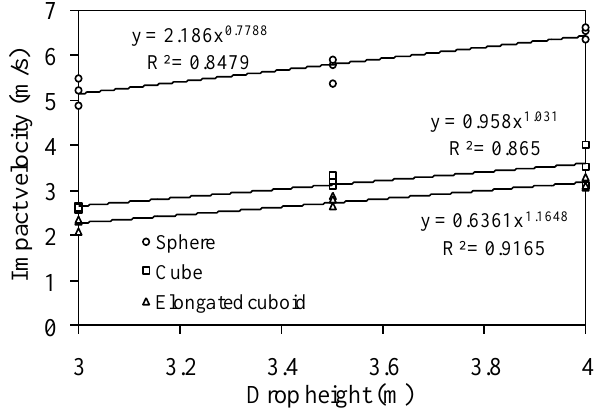
Figure 10. Positive exponential correlation between impact velocity ( v ) and drop height ( h ).